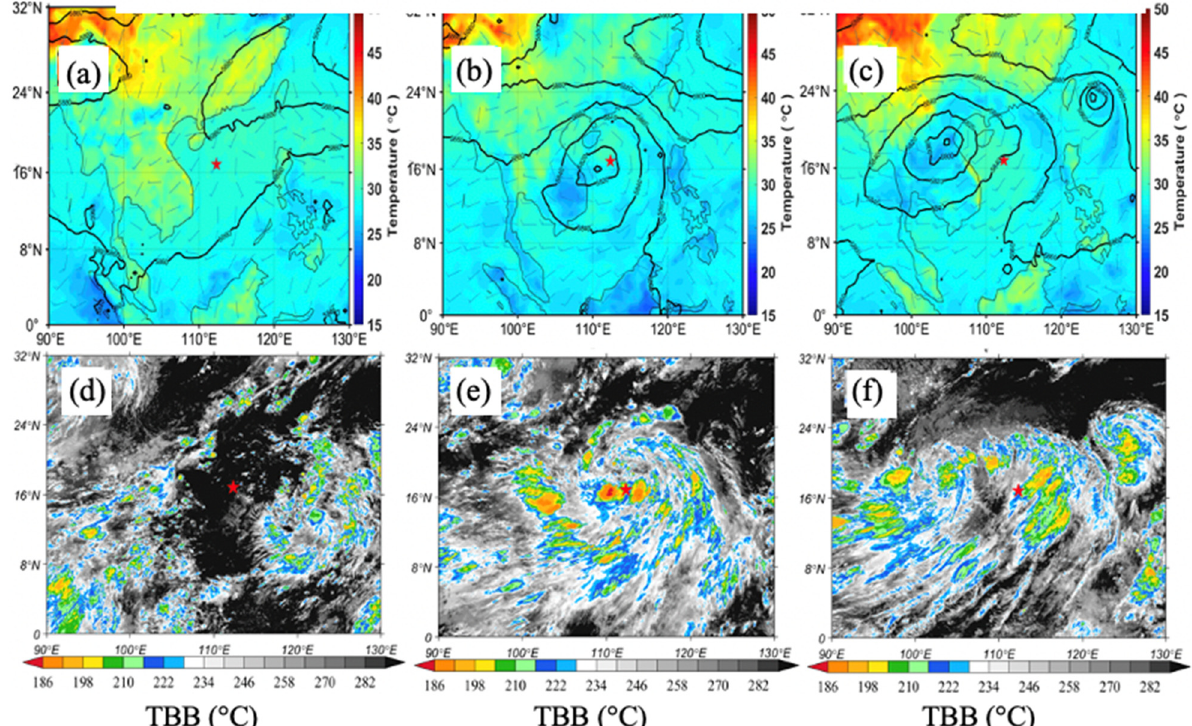
Figure 3. ( a – c ) The field of air temperature at the surface (color shading), wind field at 850 hPa (wind barb), and geopotential height at 500 hPa from GFS reanalysis (solid black lines); ( d – f ) the TBB images from the Himawari-8 geostationary satellite acquired at 06:00 UTC on 28 July, at 12:00 UTC on 31 July, and at 12:00 UTC on 2 August 2020, corresponding to three different stages of Typhoon Sinlaku (2020): ( a , d ) pre-TD stage, ( b , e ) TD stage, and ( c , f ) TS stage. The red pentagrams in all panels show the position of Xisha